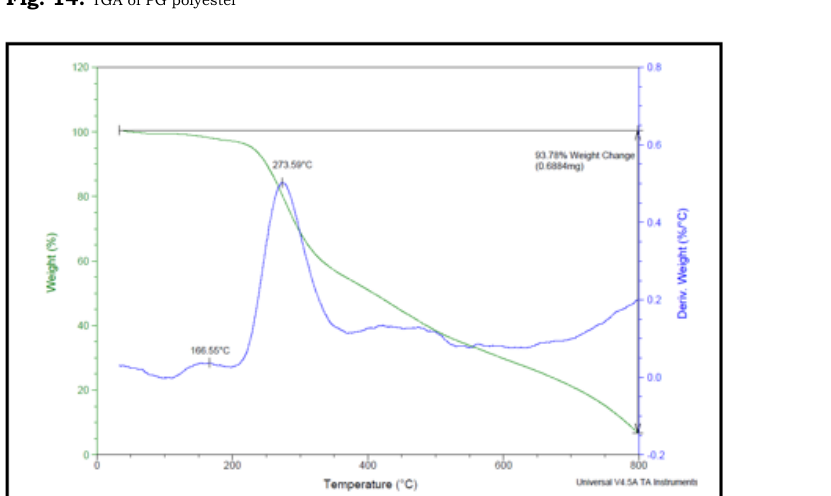
Fig. 15. TGA of PH polyester